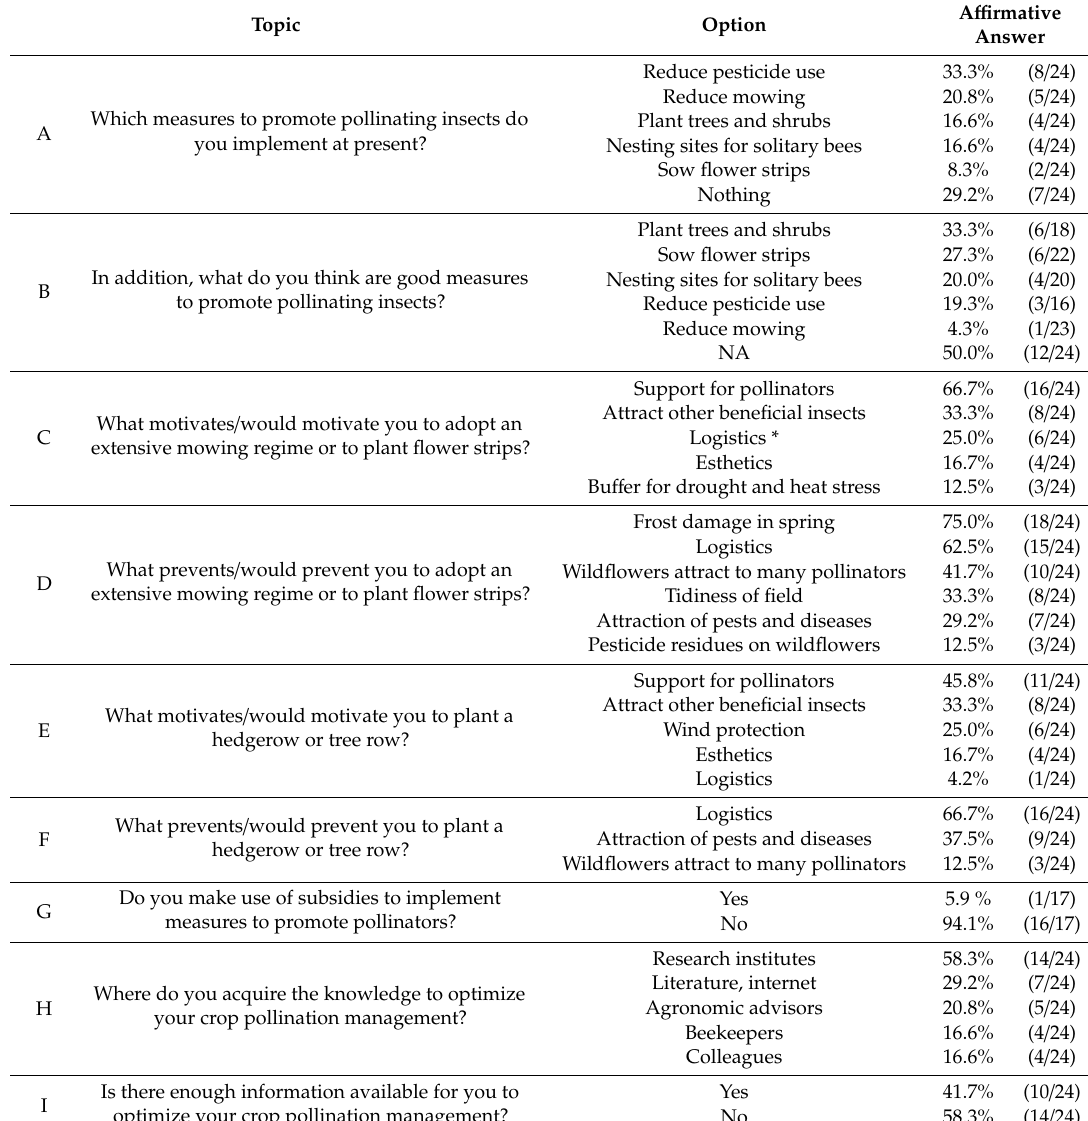
Table 2. Questions about management measures to promote crop pollinators that were covered during the semi-structured interviews with sweet cherry growers. The number of growers that gave a certain answer to each question is given (percentage and actual